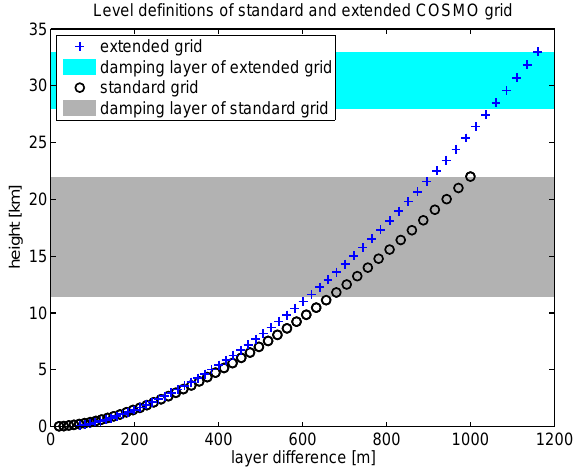
Figure 2. The vertical structure of the NCEP and ERA-Interim re- analysis used as boundary conditions.